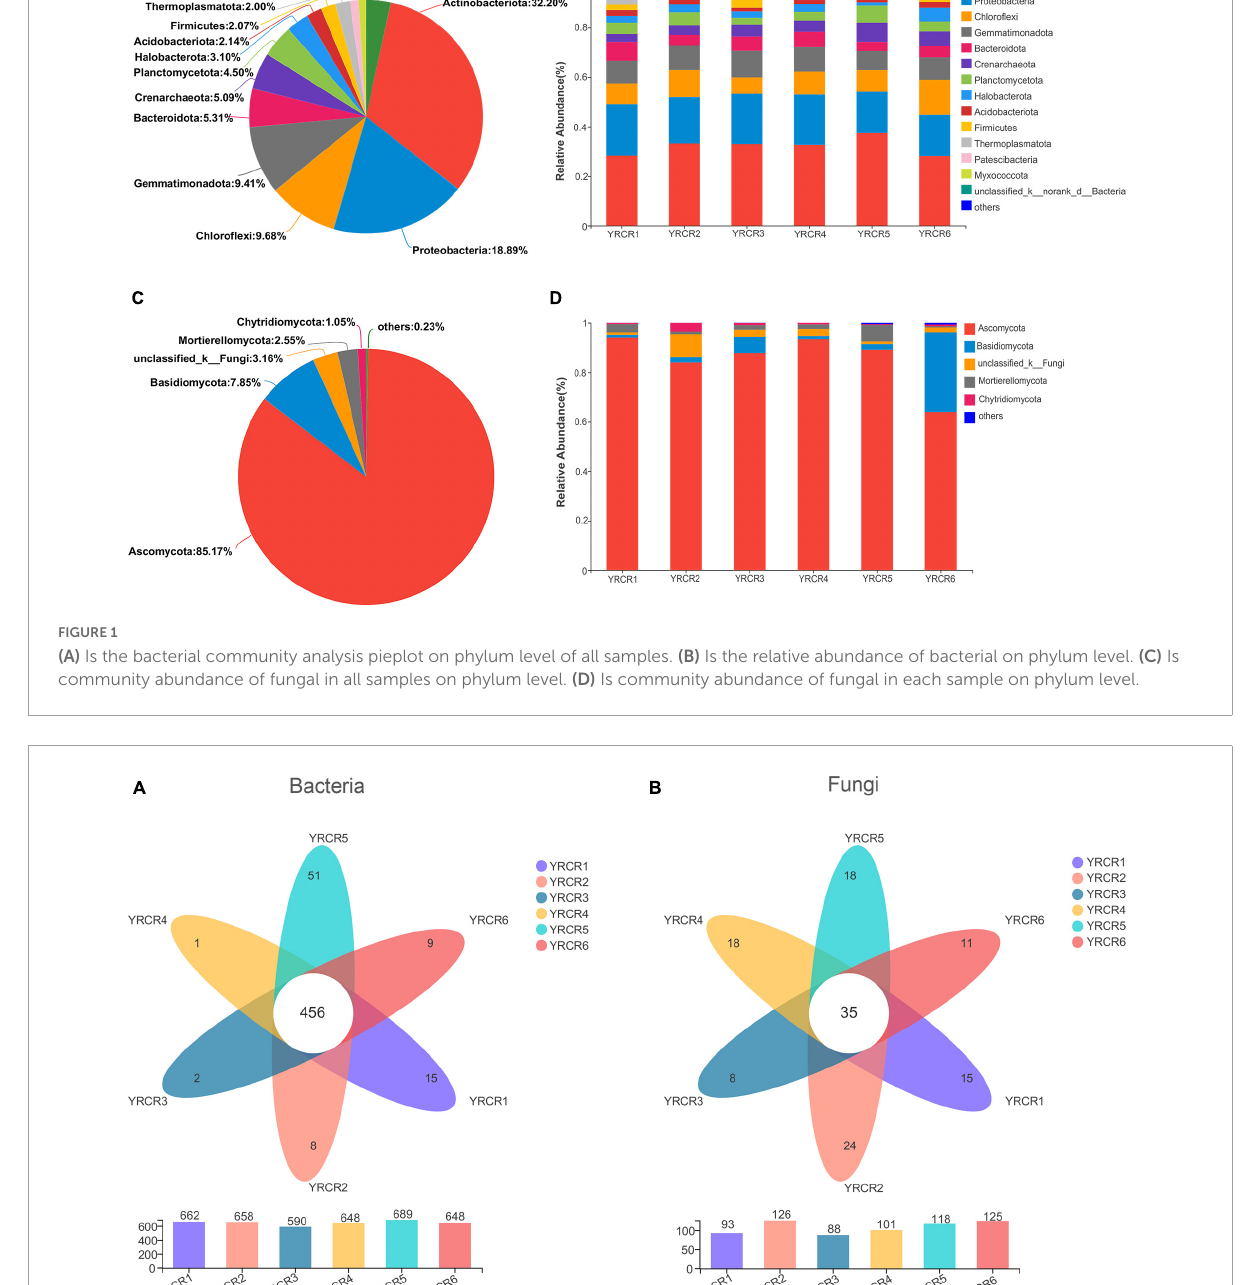
found that fungal diversity was negatively correlated with bacterial diversity in sequencing samples. YRCR6 had the highest bacterial diversity and lowest fungi diversity, YRCR5 had the highest fungal diversity and lowest bacterial diversity.